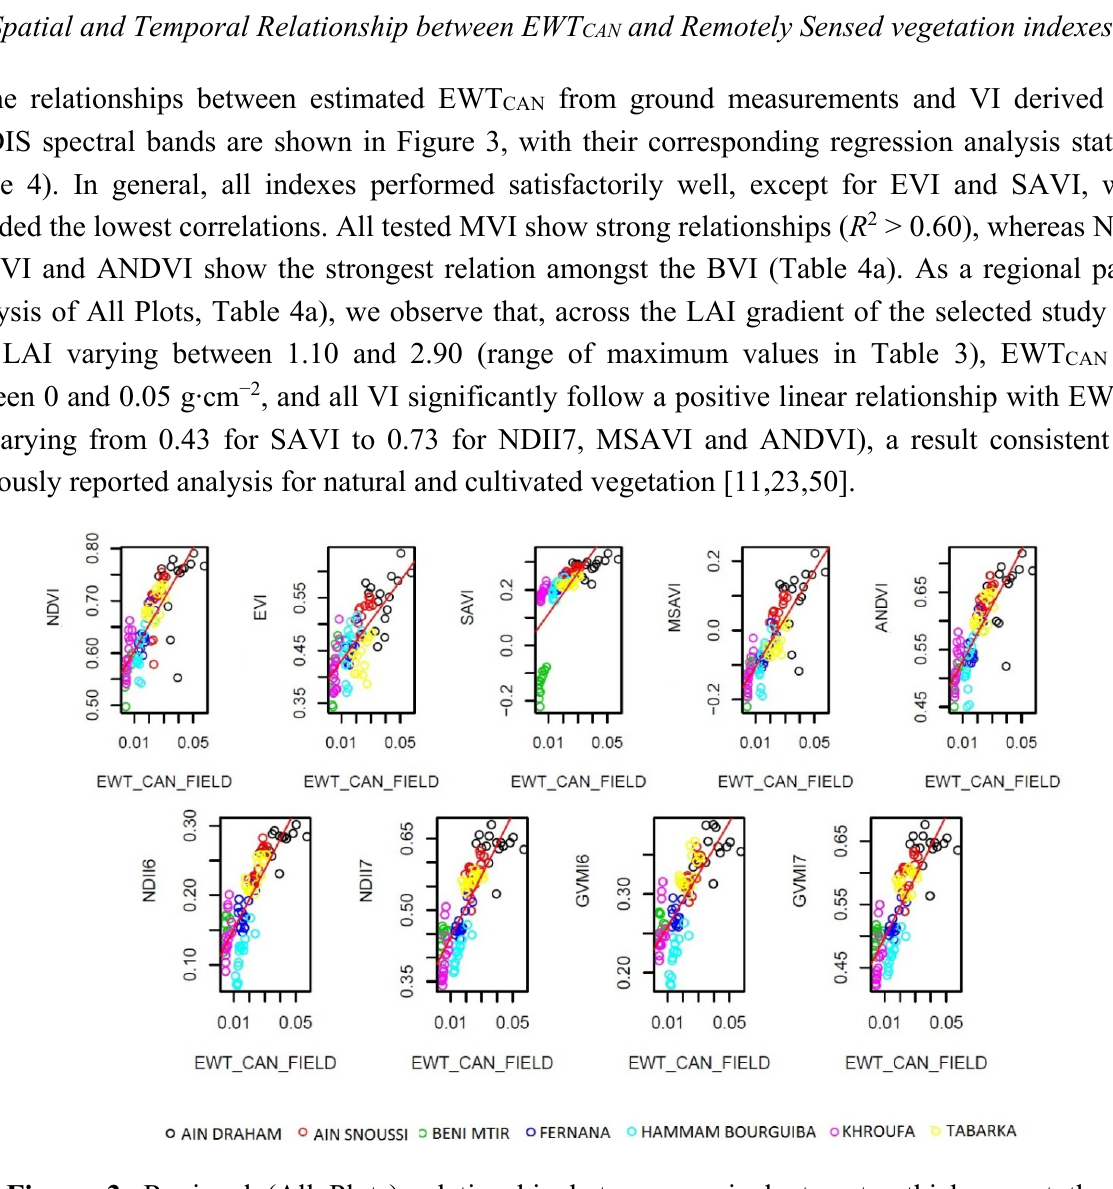
Figure 3. Regional (All Plots) relationship between equivalent water thickness at the canopy level (EWT CAN ; g∙cm −2 ) and MODIS-VI indexes with the resulting fitted linear model (red line). Colored dots represent each of the seven study